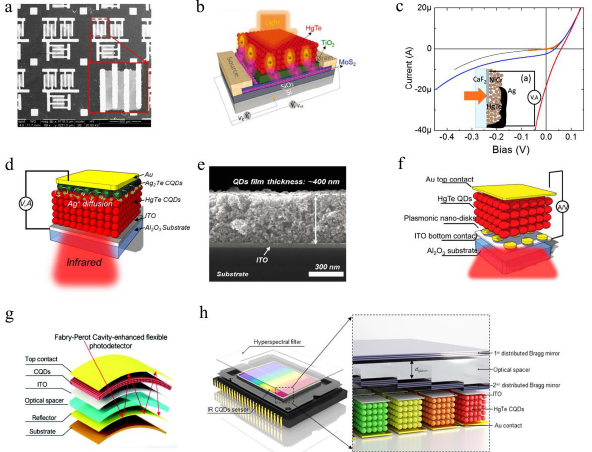
Figure 3. ( a ). Scanning electron microscopy image of a photoconductor by depositing CQDs on a Figure 3. ( a ) Scanning electron microscopy image of a photoconductor by depositing CQDs prefabricated interdigitated electrode, adapted with permission from [49]; Copyright 2016 American